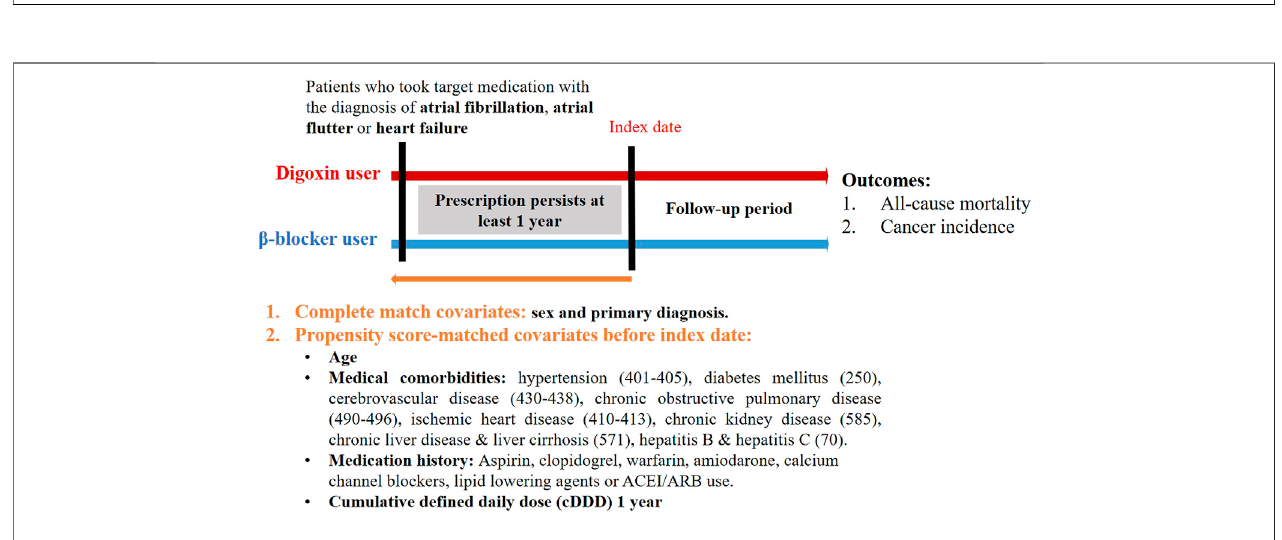
FIGURE 1 | Study fl ow chart. Nhird, national health insurance research database.